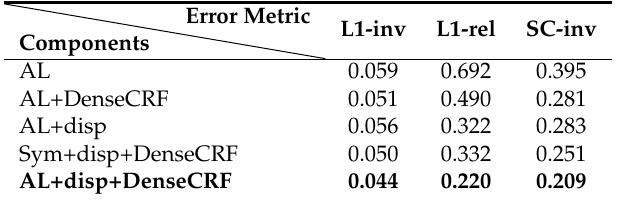
Table 3. Ablation studies of our proposed method. “AL” denotes the asymmetric structure, and “Sym” is the symmetric structure of five encoding and five decoding layers, and “disp” is the disparity estimation layer, the “DenseCRF” is the post-optimization process. The best one is highlighted in bold.